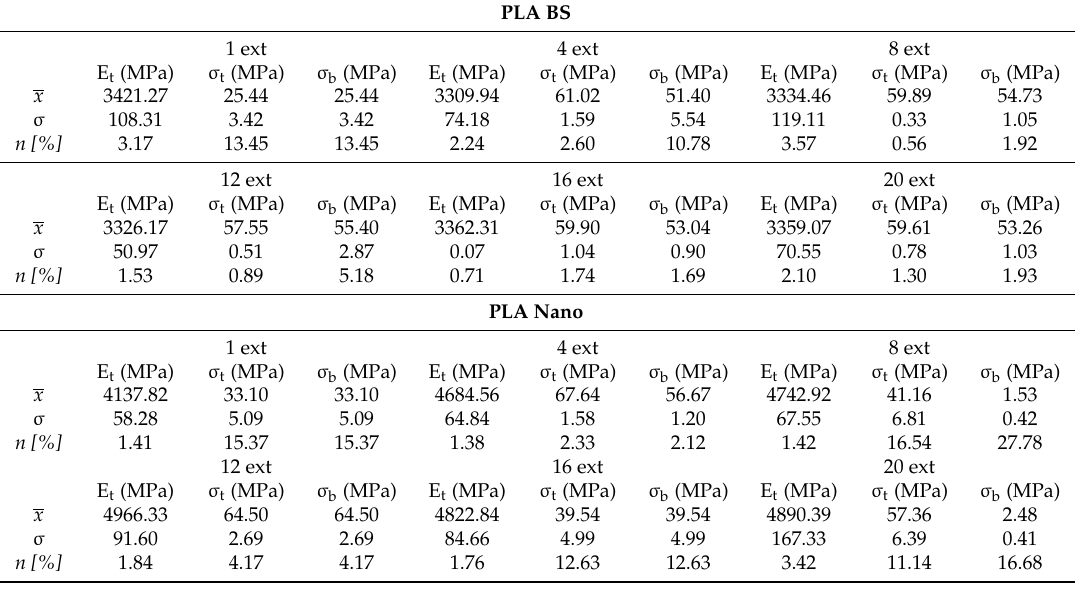
Figure 1. Flexural Modulus of the three formulations by each extrusion.